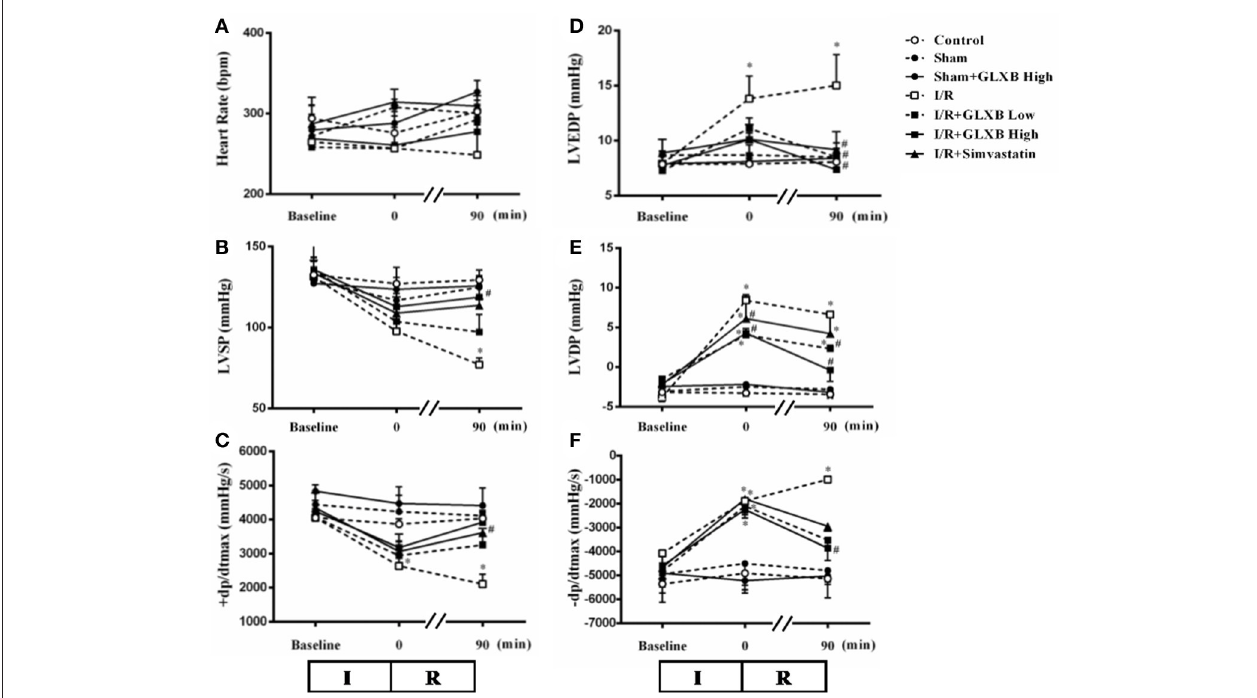
FIGURE 9 | The effect of GLXB on cardiac function in rats. Presented are the time courses of HR (A) , LVSP (B) , + dp/dtmax (C) , LVEDP (D) , LVDP (E) , and -dp/dtmax (F) in various groups, respectively. The linear mixed effects models were analyzed for repeated measurement data, and least squares means were calculated between the groups of different time points. Data are mean ± SEM, n = 6. * P < 0.05 vs. Sham group, # P < 0.05 vs. I/R